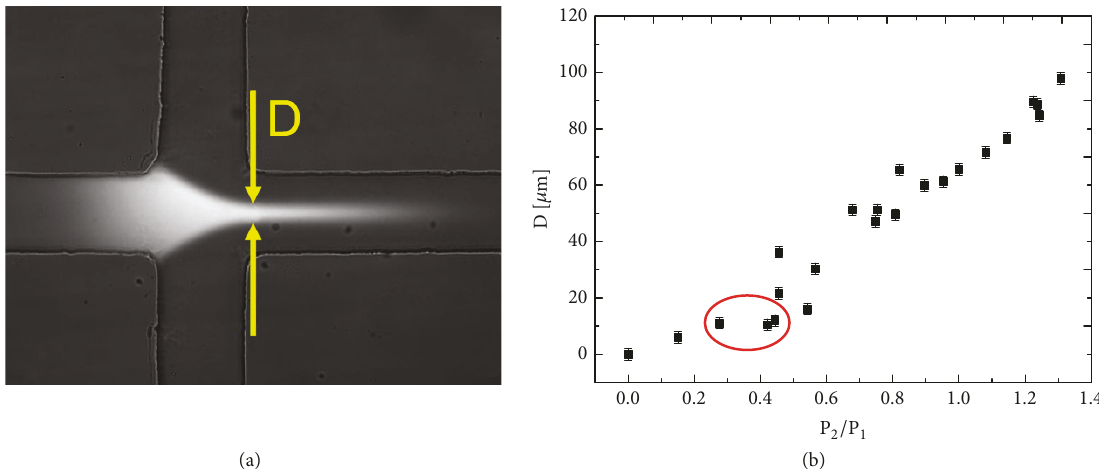
Figure 2: (a) Fluorescent image of the flow-focusing, with the fluorescein mix used as inner solution. (b) Dimension of D as function of the pressure ratio P 2 /P 1 ; the red circle underlines the selected region for the following experiment.